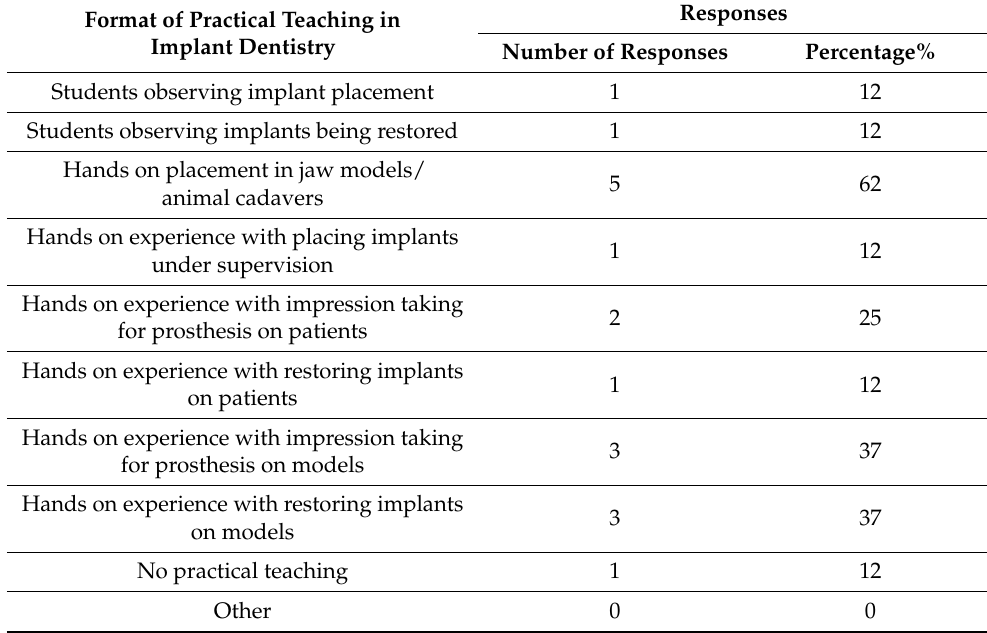
Table 1. Practical teaching of implant dentistry amongst undergraduate dental